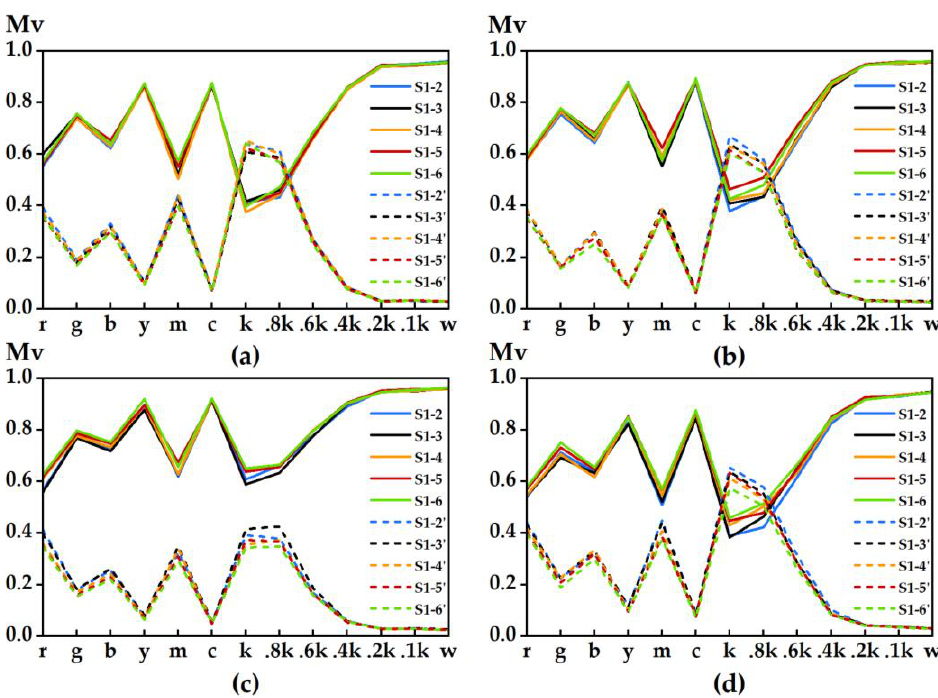
Figure 7. Similarity between color samples: ( a ) test plate I; ( b ) test plate II; ( c ) test plate III; ( d ) test plate IV. Solid lines S1-2 indicate MSSIM image-based metric curves, while dashed lines S1-2 ′ indicate iCID image-based metric curves.